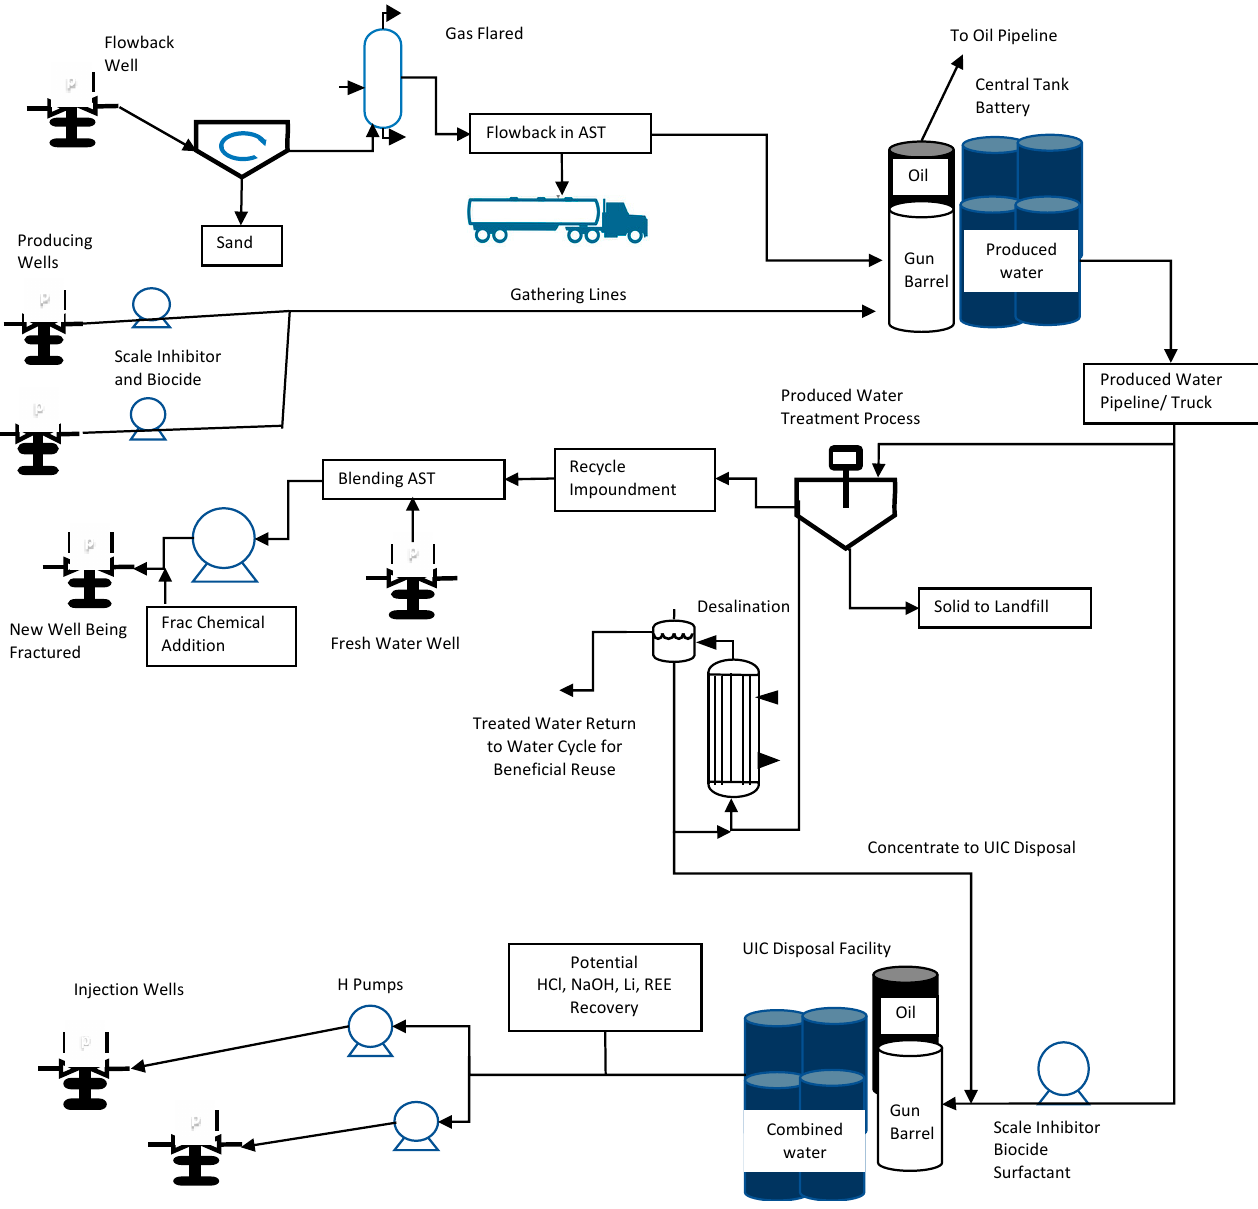
Figure 1. Schematic diagram of produced water production, transportation, treatment, reuse for hydraulic fracturing, advanced treatment for beneficial uses, and disposal. AST: above surface storage tank; UIC: underground injection control.